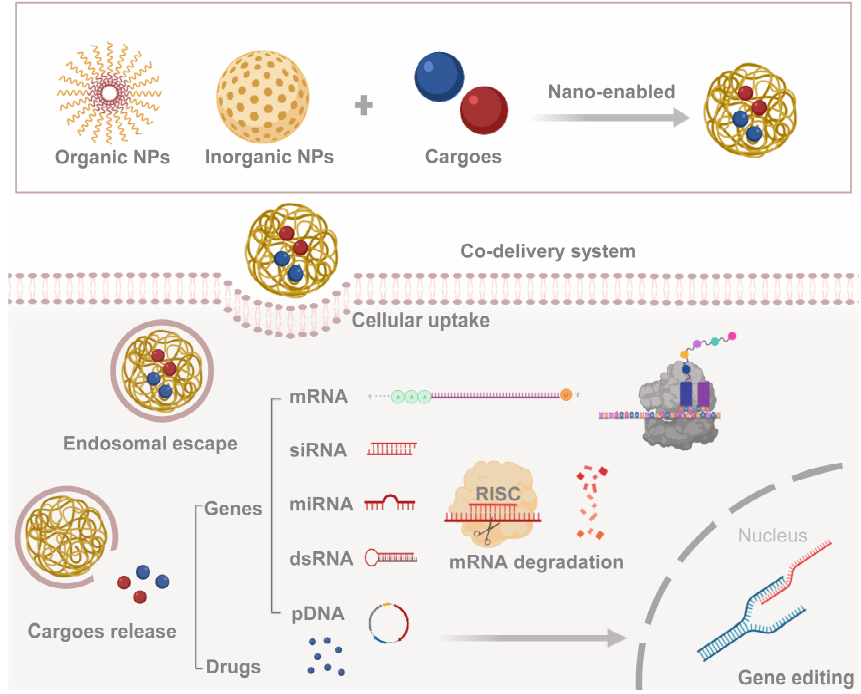
Figure 1. Combination route and mechanism of co-delivery system. Cargoes (genes or drugs) are encapsulated in nanoparticles, and then delivered into the cytoplasm through endosomal escape.